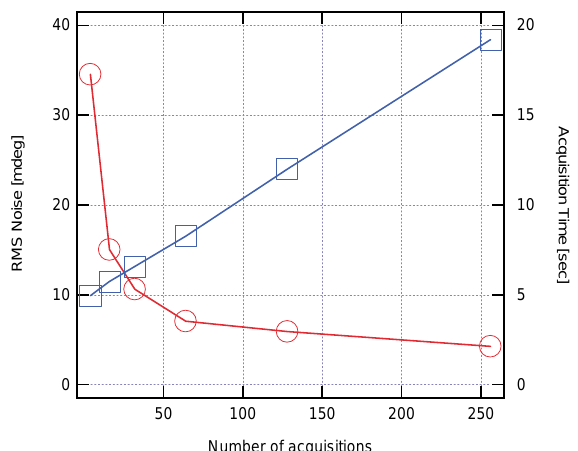
FIG. 3. (Color) Noise (rms deviation) of the relative phase mea- surement obtained in the test bench as a function of the number of acquisitions used in averaging. Also shown is the total ac- quisition time.